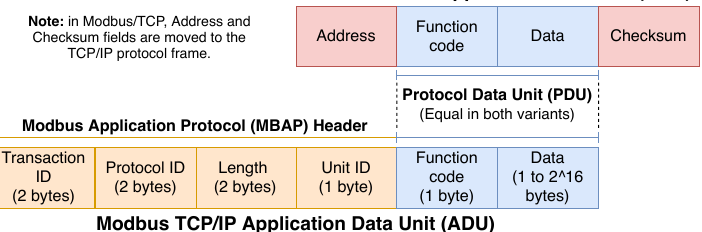
Figure 12. Modbus Application Data Unit (ADU) format.